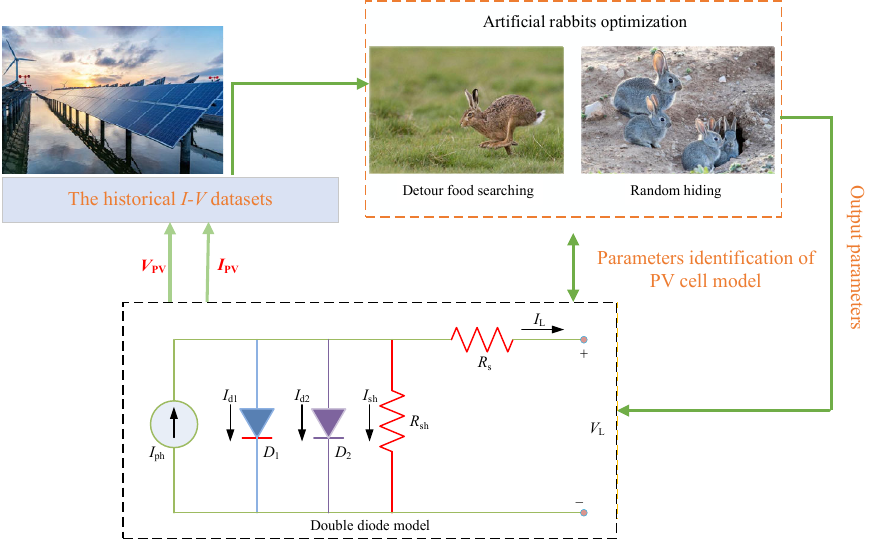
Figure 7. ARO based parameter identi fi cation framework. Table 1. Benchmark I ‐ V dataset. Table 1. Benchmark I-V dataset.